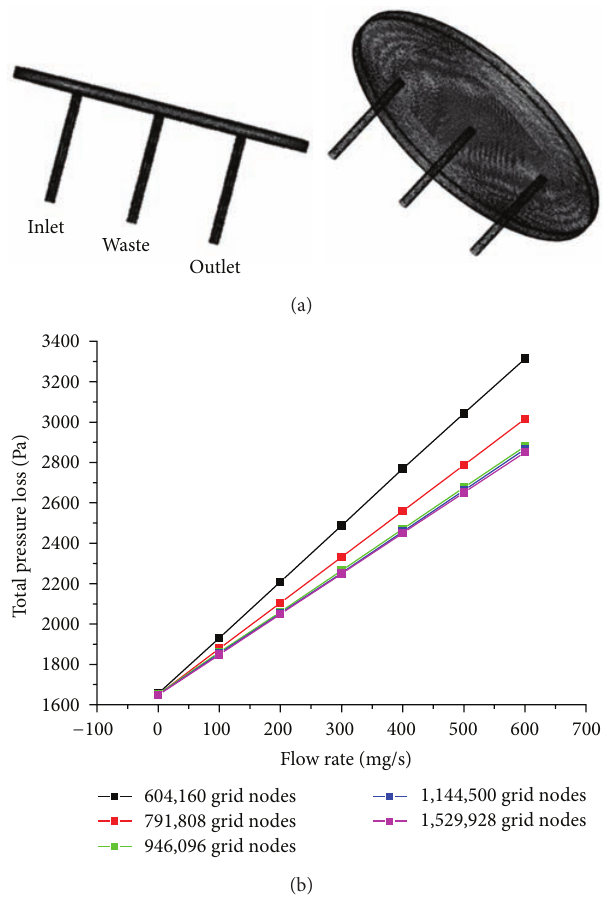
Figure 8: The grids method: (a) the side view of mesh division for cell culture internal cavity, (b) the curve result of the flow rate for outlet total pressure